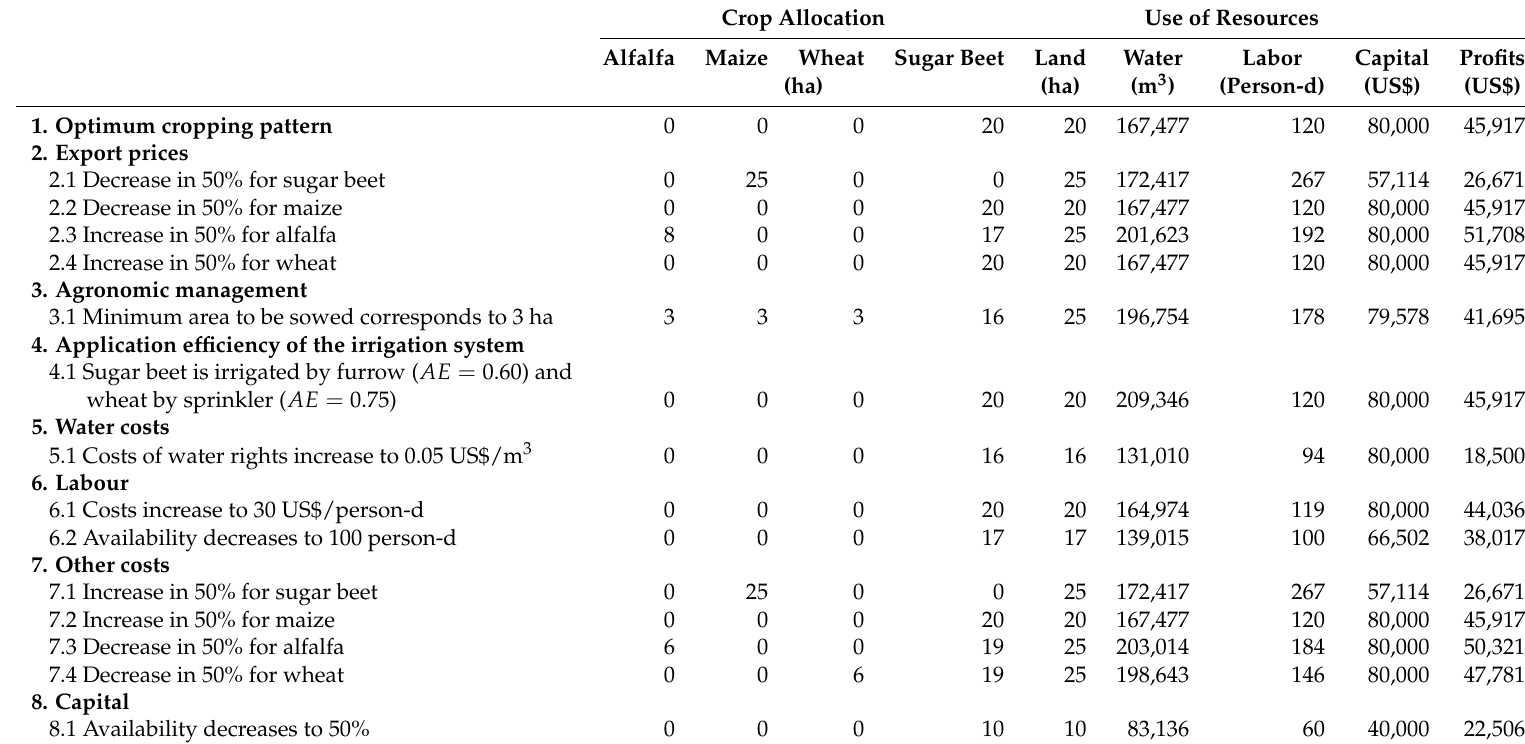
Table 4. Sensitivity analysis for scenario